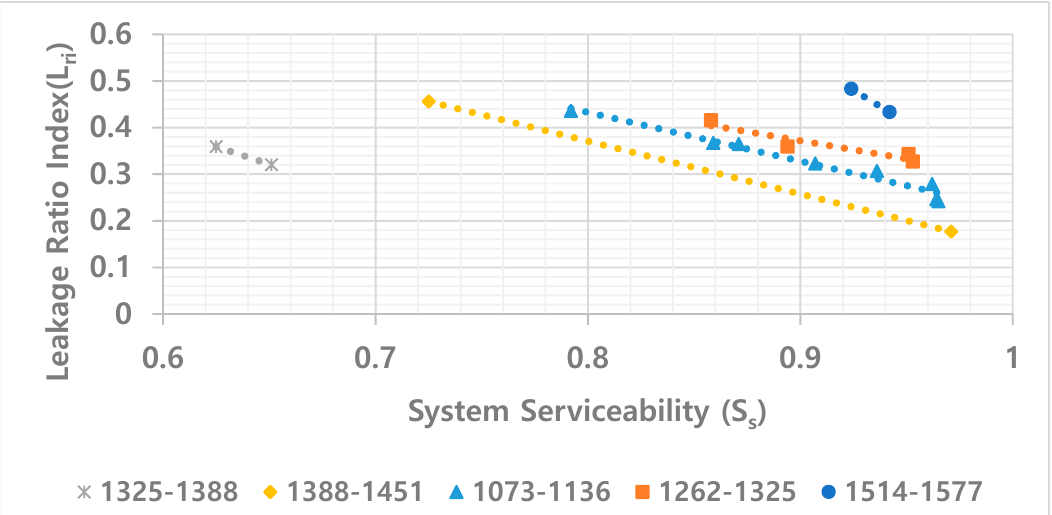
Figure 5. Relationships between S s and L ri by the section of the total supply flow rate.